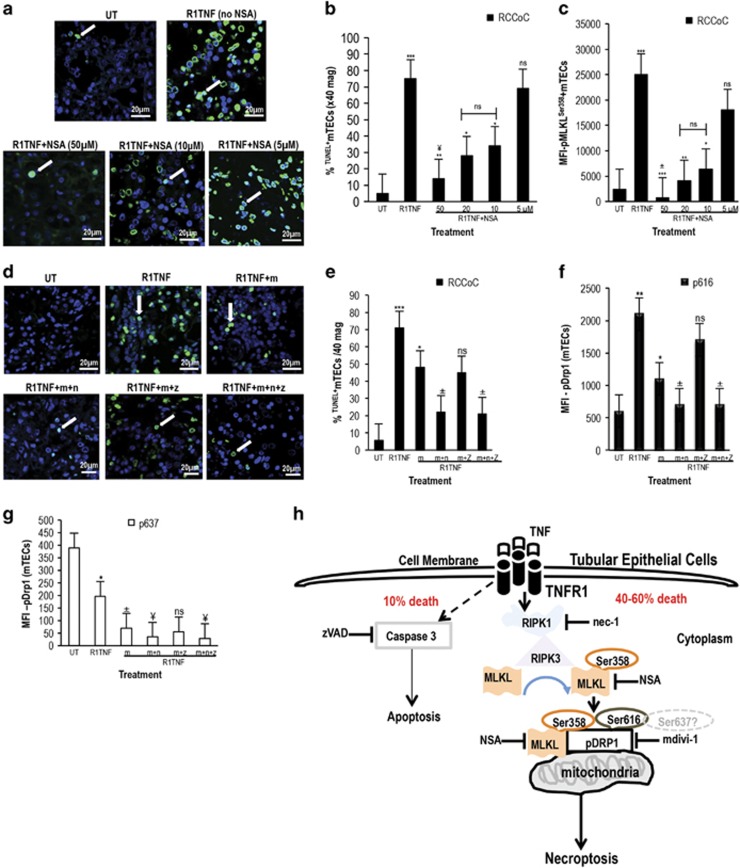
(a) Effect of necrosulfonamide (NSA) and mdivi-1 (m) in grade 1 RCC organ cultures treated with R1TNF. R1TNF alone without NSA (no NSA) induced increased levels of TUNEL+mTECs, which were significantly reduced with 50 μM NSA, and to a lesser extent, with 10 μM or 20 μM NSA (arrows). Cultures pretreated with 5 μM NSA showed comparable levels of TUNEL+mTECs as untreated cultures (UT). (b) The percentage of TUNEL+mTECs and (c) pMLKLSer358 expression presented as mean fluorescent intensity (MFI) in similar cultures. ***P<0.0001 versus UT,**P<0.001 versus R1TNF; *P<0.05 versus R1TNF; ¥P<0.05 versus R1TNF (+20 or 10μM); ±P<0.001 versus R1TNF (+20 or 10 μM); ns, not significant. (d) In comparison with UT, which show a rare TUNEL+mTECs, R1TNF alone (without m) induced increased levels of TUNEL+mTECs, significantly reduced by m (10 μM) with no effect by zVAD.fmk (m+z) but a marked reduction by nec-1 (m+n) comparable with cultures pretreated with a combination of zVAD.fmk and nec-1 (m+n+z). (e) The percentage of TUNEL+mTECs and (f and g) the mean fluorescence intensity (MFI) for pDrp1Ser616 and pDrp1Ser637 in similar cultures. ***P<0.0001 versus UT (e), **P<0.01 versus UT (f), *P<0.05 versus R1TNF, ±
P<0.05 versus R1TNF+m. (g) *P<0.05 versus UT, ±P<0.5 versus R1TNF, ¥P<0.05 versus R1TNF+m; ns, not significant. Bars=mean±S.E.M.; n=3 independent experiments from six separate organ culture experiments with similar results. (h) Schematic diagram of the consequences of R1TNF-mediated necroptosis in mTEC in RCC; ligation of TNFR1 results in the recruitment of RIPK1, facilitating its interaction with RIPK3, which in turn recruits and phosphorylates MLKL at Ser358 and Drp1 at Ser616 thus causing their co-localization with the mitochondria. A separate process causes a reduction in pDrp1 at ser637. Nec-1 inhibits RIPK1, and NSA inhibits MLKL and mdivi-1 inhibits Drp1 inhibiting cell death